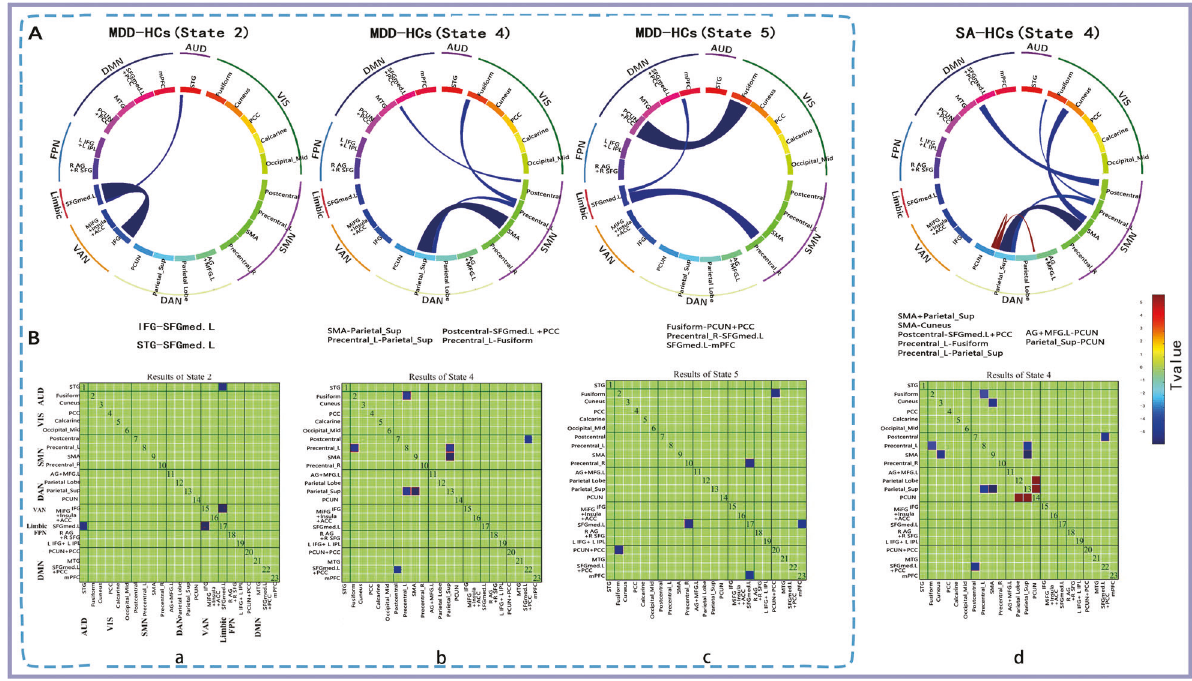
Fig. 3 Functional network connectivity differences between patients with major depressive disorder (MDD) and HCs in state 2, state 4, and state 5 and between SAs and HCs in state 4. Signi fi cance was corrected using the false-discovery rate (FDR) over the total of 253 (23 × 22/2) dFNC values in each state. The circles indicate signi fi cant ( P < 0.05, FDR-corrected) t tests. A wider line means a large group difference. Red lines represent increased connectivity, while blue lines represent decreased connectivity between two groups. AUD auditory network, VIS visual network, SMN, somatomotor network, DAN dorsal attention network, VAN ventral attention network, LN limbic network, FPN frontoparietal network, DMN default mode network, L left, R right, STG superior temporal gyrus, Fusiform fusiform gyrus, Cuneus, cuneus cortex, PCC posterior cingulate cortex, Calcarine calcarine cortex, Occipital_Mid middle occipital gyrus, Postcentral postcentral gyrus; Precentral precentral gyrus, SMA supplementary motor area, AG angular gyrus, MFG middle frontal gyrus, Parietal_Sup superior parietal gyrus, PCUN precuneus, IFG inferior frontal gyrus, MiFG middle inferior frontal gyrus, lnsula insular cortex, ACC anterior cingulate cortex, SFGmed superior frontal gyrus medial, SFG, superior frontal gyrus, IPL inferior parietal lobule, MTG middle temporal gyrus, mPFC medial prefrontal